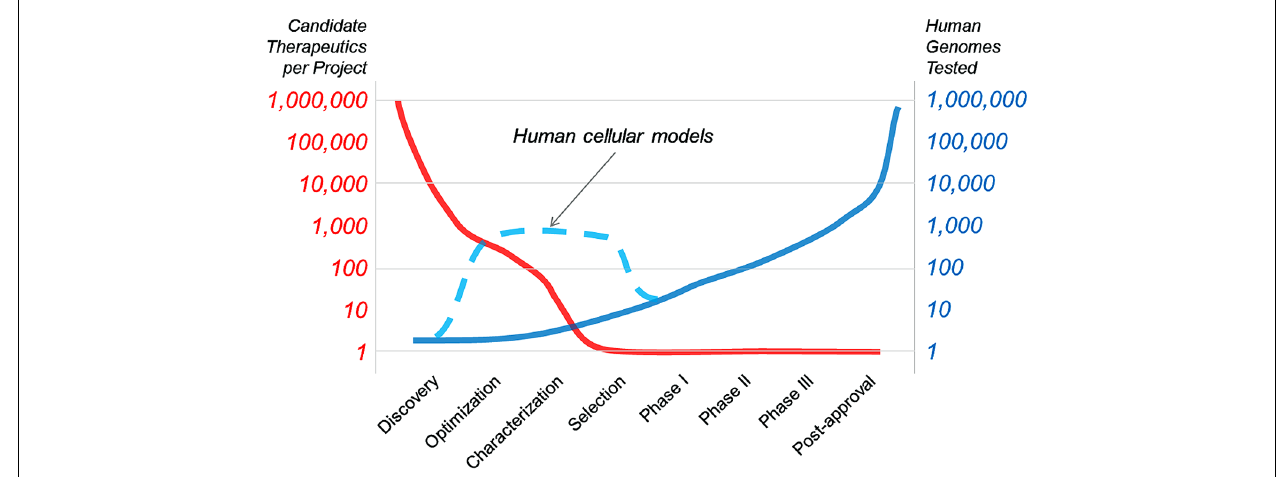
FIGURE 1 |The goal of “ in vitro clinical trials” is to use genetically characterized cell panels in an effort to reduce the number of potential therapies dropping out of clinical development before entering clinical trials and to better inform patient stratification.